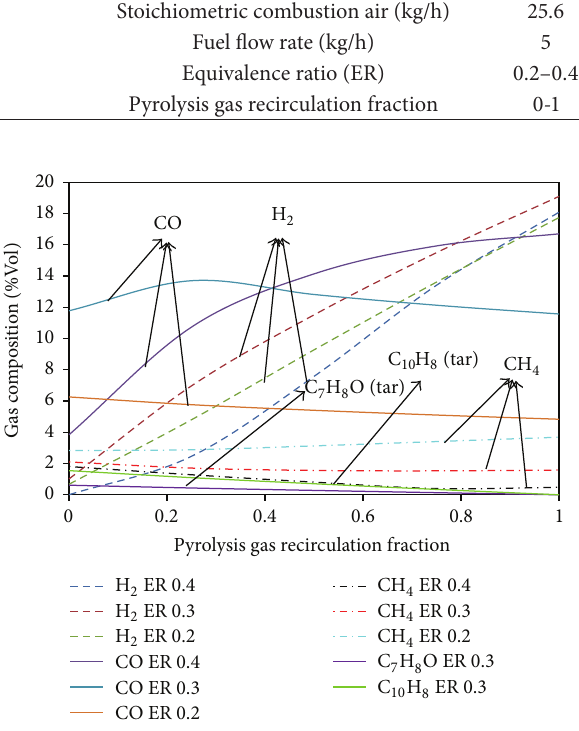
Figure 3: Gasification product according to pyrolysis gas recircula- tion fraction and equivalence